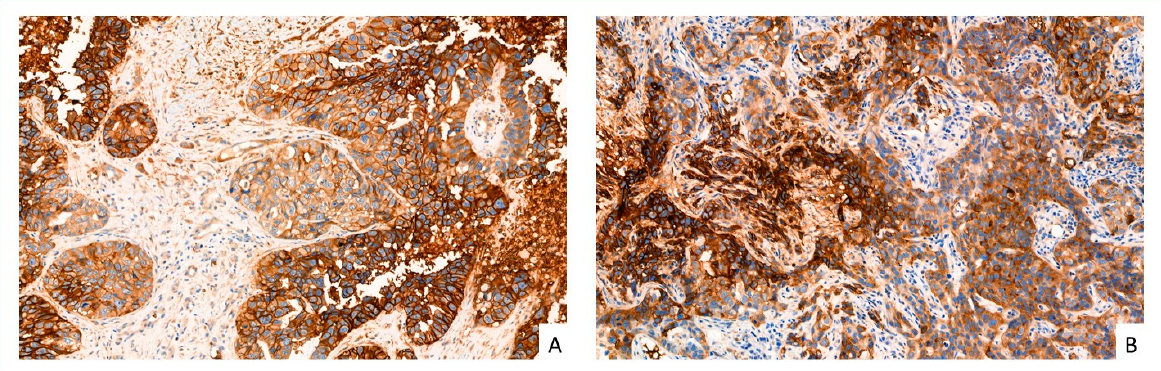
Figure 3. GLUT-1 IHC overexpression in invasive breast cancer cells. ( A ) invasive breast carcinoma NST of triple-negative molecular type, overexpressed GLUT-1 (score 3) (×240 magnification). ( B ) invasive breast carcinomas NST, HER2 enriched molecular type, overexpressed GLUT-1 (score 3) (×300 magnification).